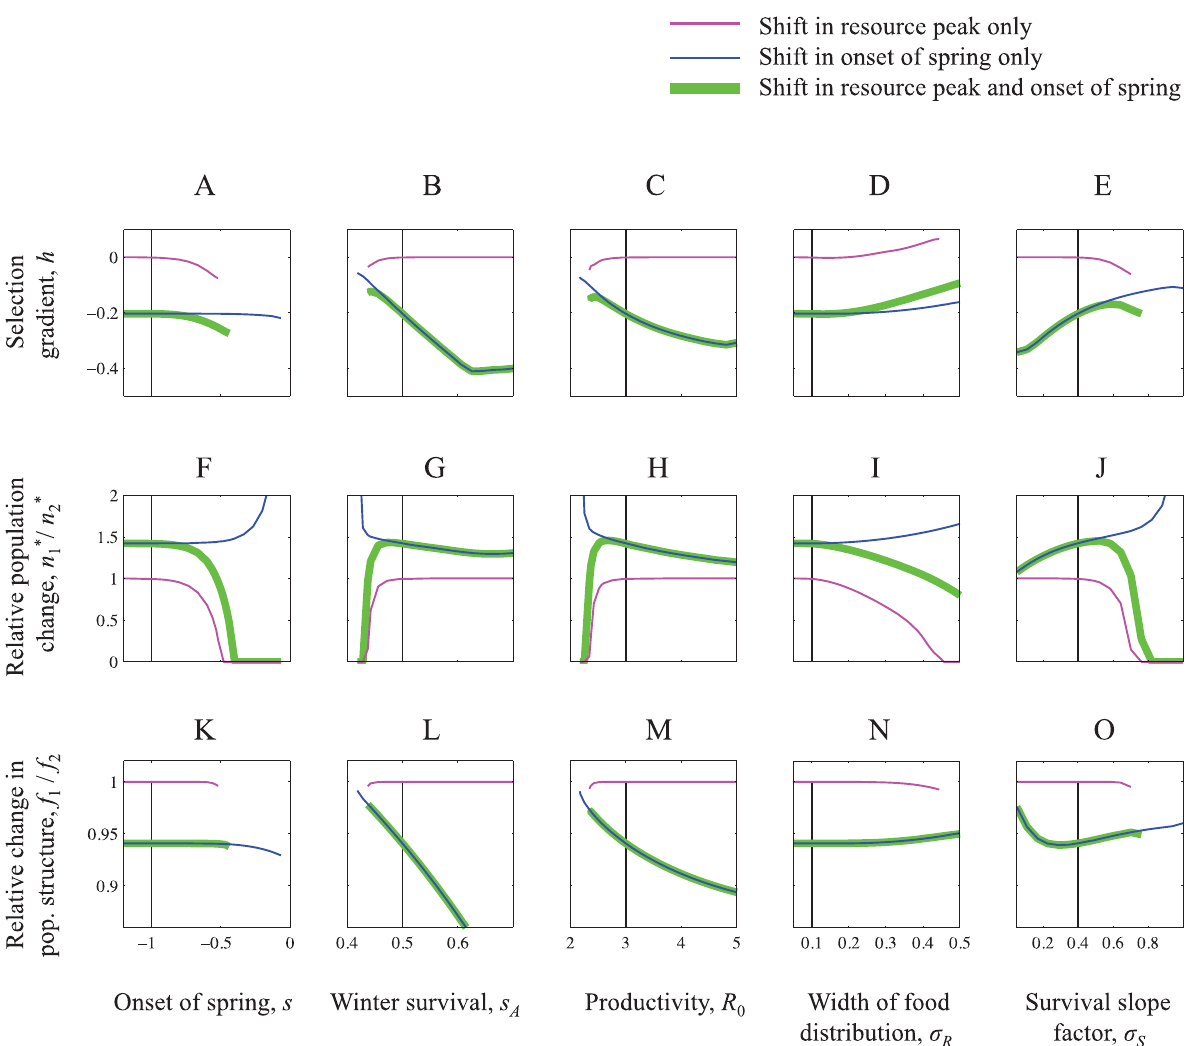
Figure 3. Selective and demographic responses to changed seasonal environments. The figure shows effects of shifts in the timing of the resource peak ( r , purple), in the onset of spring ( s , blue) and joint shifts in both these components of the seasonal environment ( s and r , green). The top row of panels ( A – E ) shows how selection gradients (from Equation 12) changes due to these environmental changes. Note that the selection gradient is equal to zero for the ESS prior to change. The middle row of panels ( F – J ) shows the relative population change, defined as n 2* / n 1* where n 1* and n 2* denote the equilibrium density before and after the change, respectively. The bottom row of panels ( K – O ) shows / f where f and f is the fraction of the relative change in population structure, defined as f 2 1 1 2 young at equilibrium before and after change, respectively. Absence of effect corresponds to selection gradients equal to zero, and the relative changes in population density and population structure equal to one. In cases where population density is zero after the change, the lines in corresponding panels are discontinued. The parameters s and r were reduced with 0.5 units in the scenarios in which they changed. Parameter values are otherwise as in Figure 2, and with the vertical solid line indicating the same parameter values across